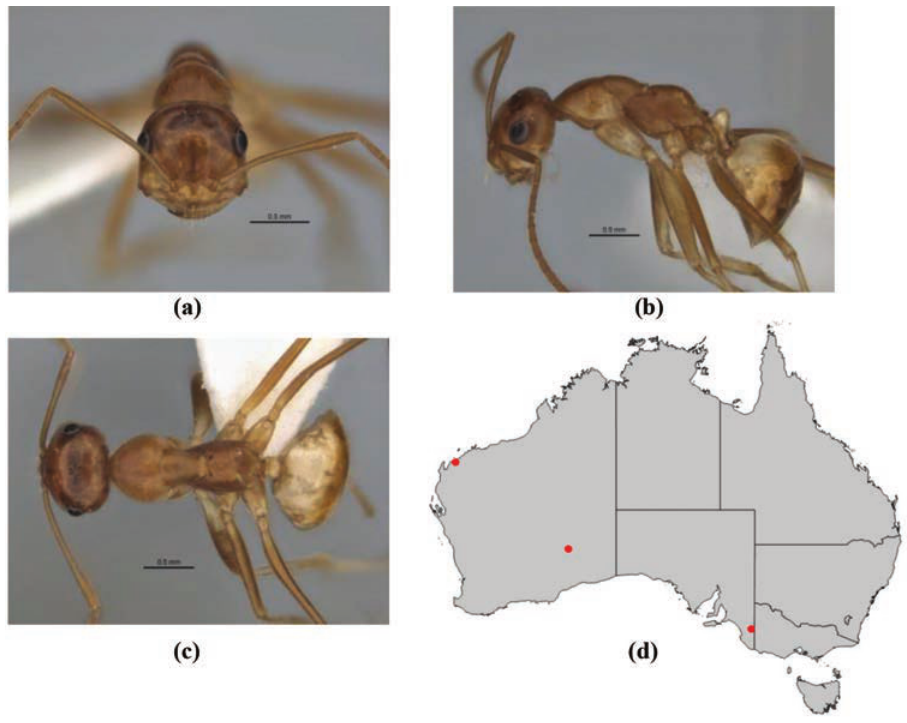
Figure 29. Melophorus subulipalpus sp. n.: minor worker holotype (JDM32-004701) frons ( a ), profile ( b ) and dorsum ( c ); distribution map for the species ( d ). Low resolution scale bars: 0.5 mm ( a–c ). microreticulate; anterior mesosoma in profile weakly elevated anteriad, thereafter gen- tly sinuate, pronotum and mesonotum on same plane; erect pronotal setae absent; in profile, metanotal groove shallow, indicated mainly by an angle; propodeum shining and uniformly striolate, or matt or with a weak sheen and microreticulate; propodeum angulate, propodeal angle blunt; length ratio of propodeal dorsum to its declivity be- tween1:1 and 1:2; erect propodeal setae always absent; appressed propodeal setulae long, each reaching setae behind and in front, but not forming pubescence; propodeal spiracle situated on or beside declivitous face of propodeum, and shorter (length < 0.50 × height of propodeum). Petiolar . In profile, petiolar node subcuboidal, vertex bluntly rounded; in full-face view, shape of petiolar node tapered with blunt vertex; node shin- ing and distinctly shagreenate-microreticulate or superficially microreticulate. Gaster . Gaster weakly shining with indistinct shagreenation, or shining, shagreenate (‘LP re- cord’ appearance); pilosity of first gastral tergite consisting of well-spaced short, incon- spicuous, appressed setae only, erect setae always absent. General characters . Colour pale brownish-yellow to tan . Measurements. Worker (n = 4): CI 102–108; EI 26–30; EL 0.22–0.25; HL 0.70–0.93; HW 0.72–0.93; ML 1.15–1.53; MTL 0.97–1.29; PpH 0.12–0.15; PpL 0.49–0.63; SI 135–140; SL